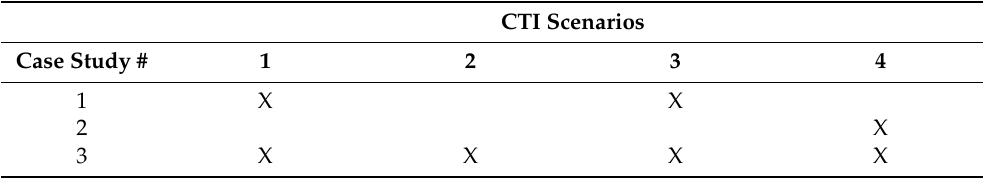
Table 3. Case studies differences in relation to CTI